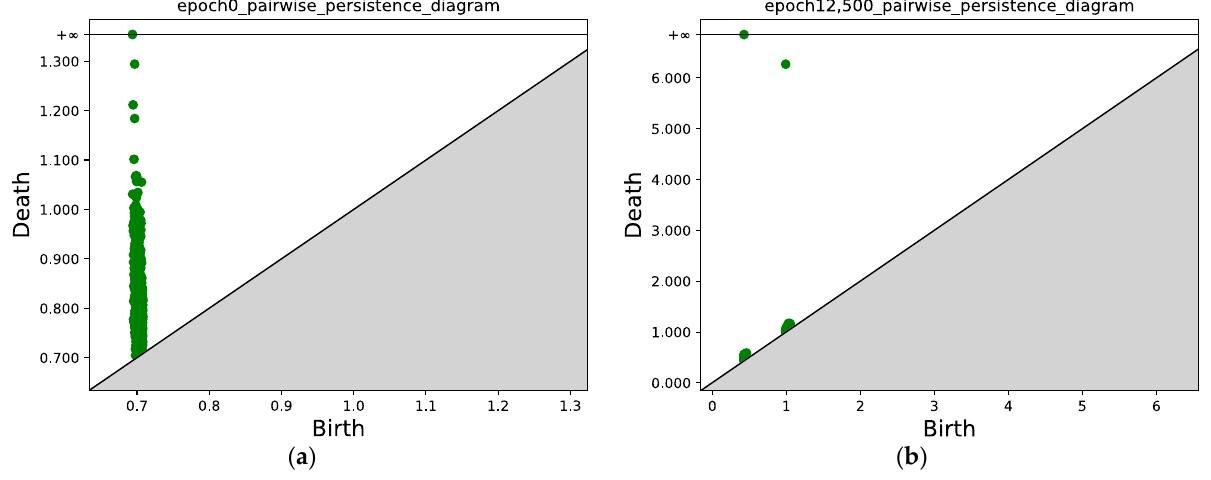
Figure 12. ( a ) Persistence diagram obtained via persistent homology at epoch 0. ( b ) Persistence diagram after 12,500 epochs. Two connected components can be identified; the points with x ≈ 0.5 correspond to the first connected component (class 1), and the points with x ≈ 1.0 correspond to the second connected component (class 2).